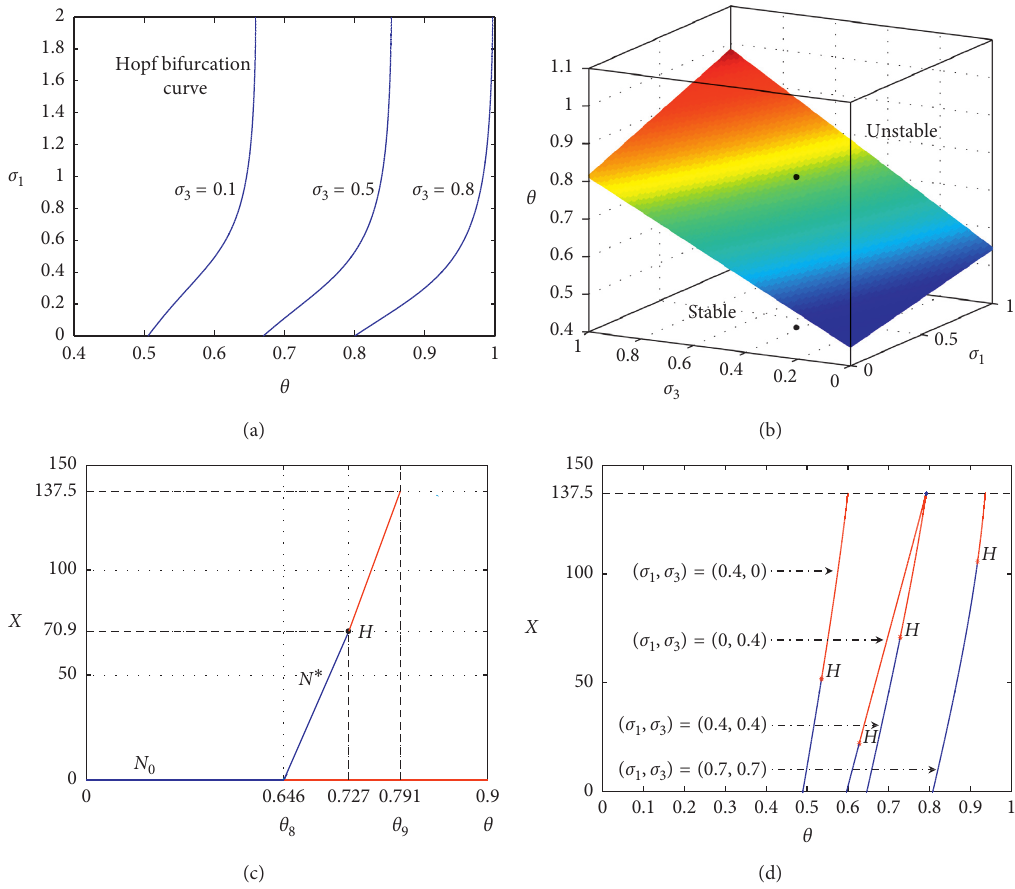
parameter plane. N ∗ is stable to 1 is stable below the surface and unstable 0